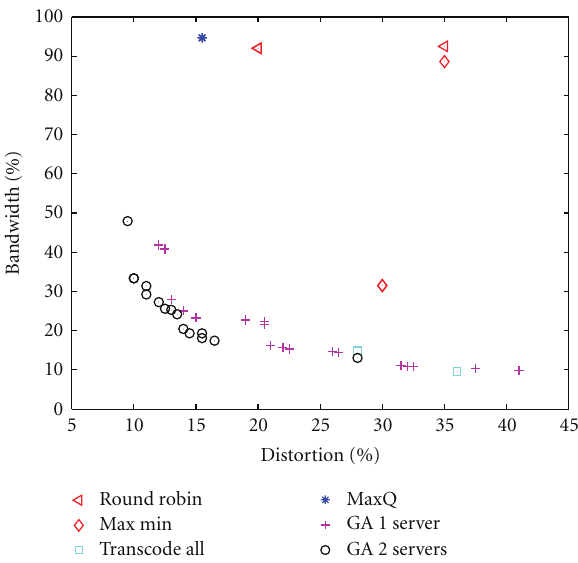
Figure 9: Projection onto energy-distortion